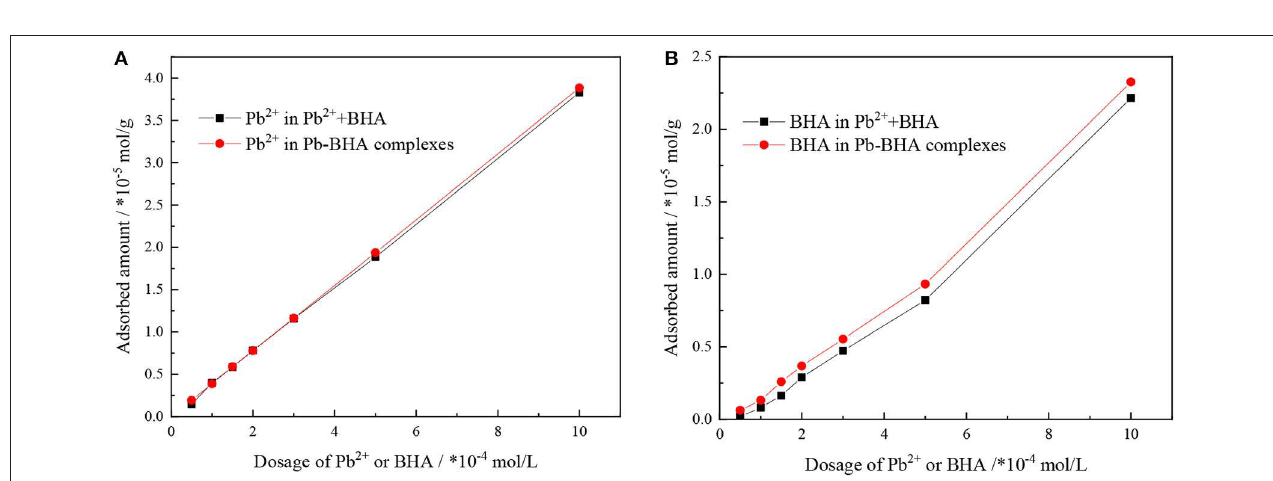
FIGURE 3 | Adsorbed amounts of (A) lead ions and (B) BHA on scheelite surface at different concentrations of lead ions and BHA (pH = 9.0 ± 0.2, C Pb : C BHA =